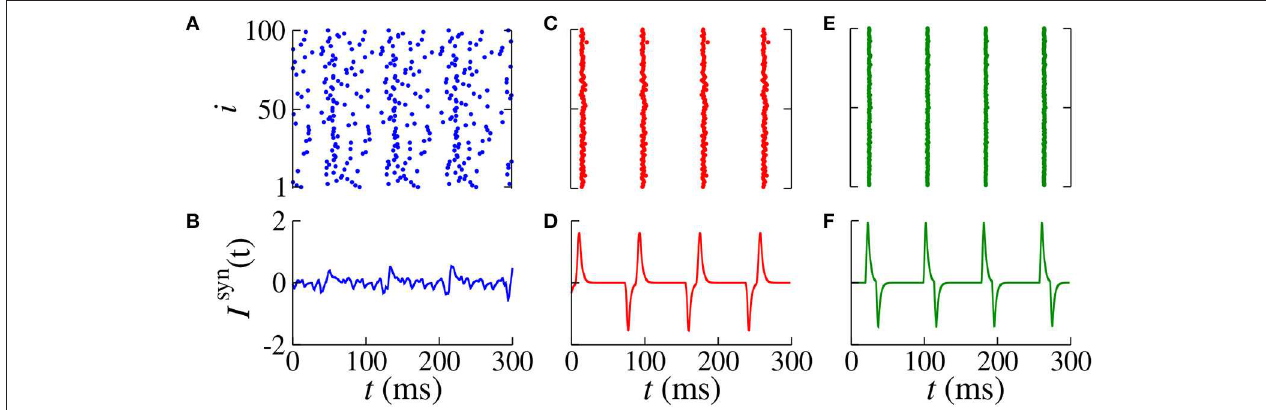
FIGURE 4 | Raster plot (top) and I syn ( t ) (bottom) for g exc = 0.2 nS, g = 6, and d exc = 75 ms for different values of d inh (blue circles in Figure 3 ). We consider (A,B) d inh = 70 ms (blue), (C,D) d inh = 60 ms (red), and (E,F) d inh = 10 ms (green).